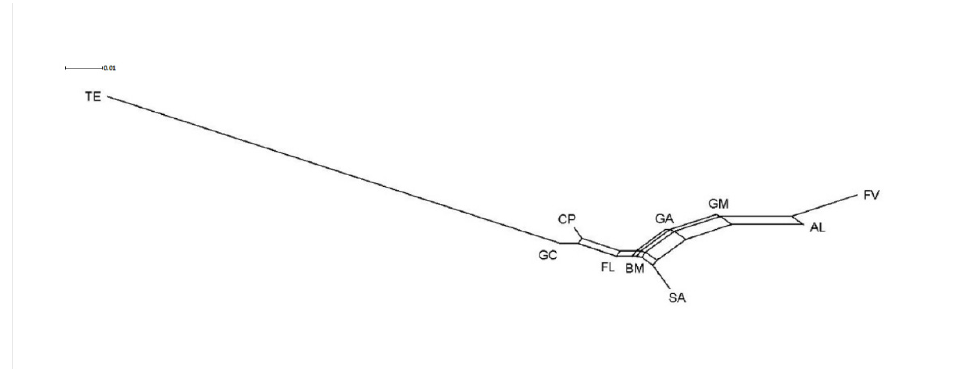
Figure 1. Pairwise F ST genetic distance tree between the goat population/breeds (eight from Central and Southern Italy and two cosmopolitan goat breeds).BM: Bianca Monticellana; CP: Capestrina; FV: Facciuta della Valnerina; FL: Fulva del Lazio; GA: Garganica; GC: Grigia Ciociara; GM: Grigia Molisana; TE: Teramana; AL: Alpine; SA: Saanen.